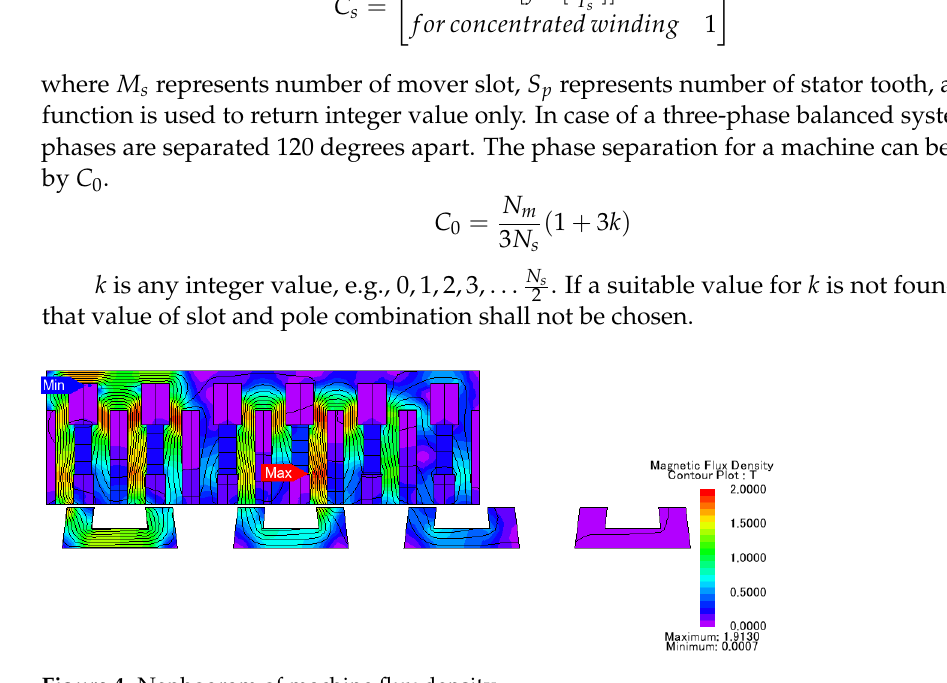
Figure 4. Nephogram of machine flux